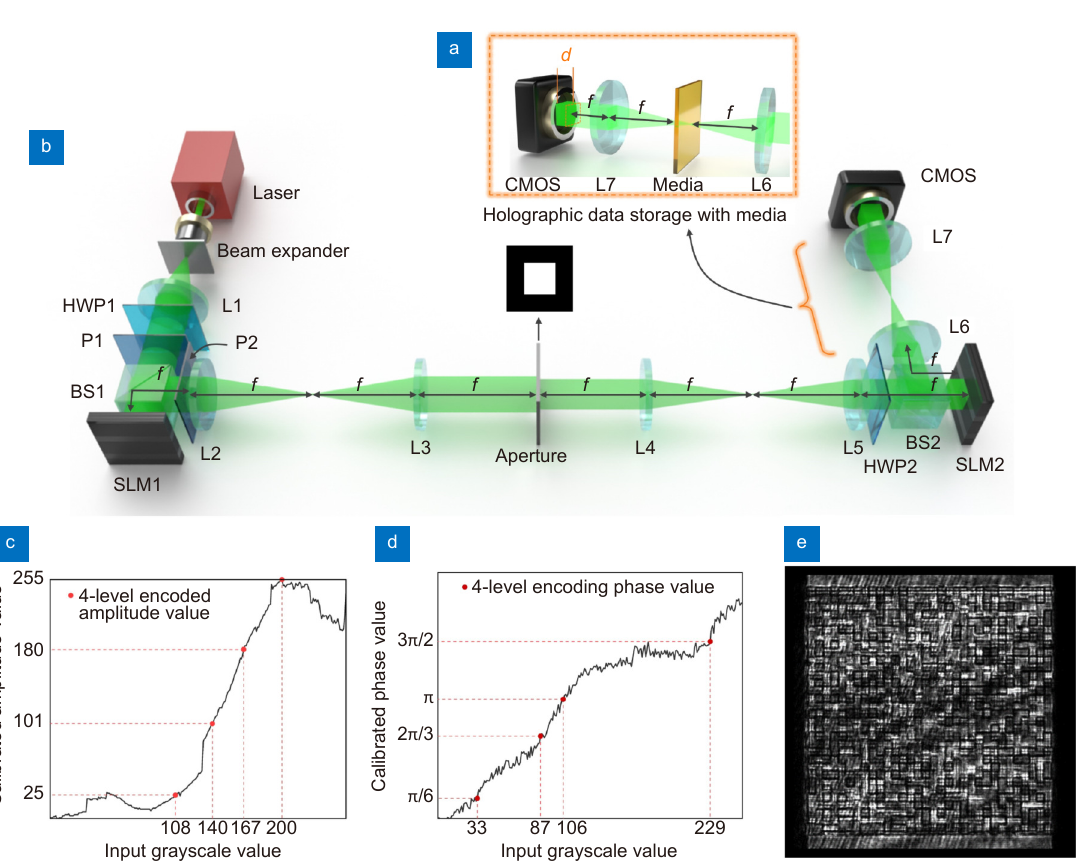
Fig. 9 | ( a ) Recording and reading system of HDS. ( b ) Experimental setup. BS: beam splitter; HWP1, HWP2: half-wave plate; L1: collimating lens ( f = 300 mm); L2–L7: relay lens ( f = 150 mm); SLM1: amplitude-modulated spatial light modulator; SLM2: phase-modulated spatial light modulat- or; P1, P2: linear polarizer, P1 is horizontally polarized and P2 is vertically polarized. ( c ) Calibration curve of SLM1. ( d ) Calibration curve of SLM2. ( e ) Intensity image captured by the